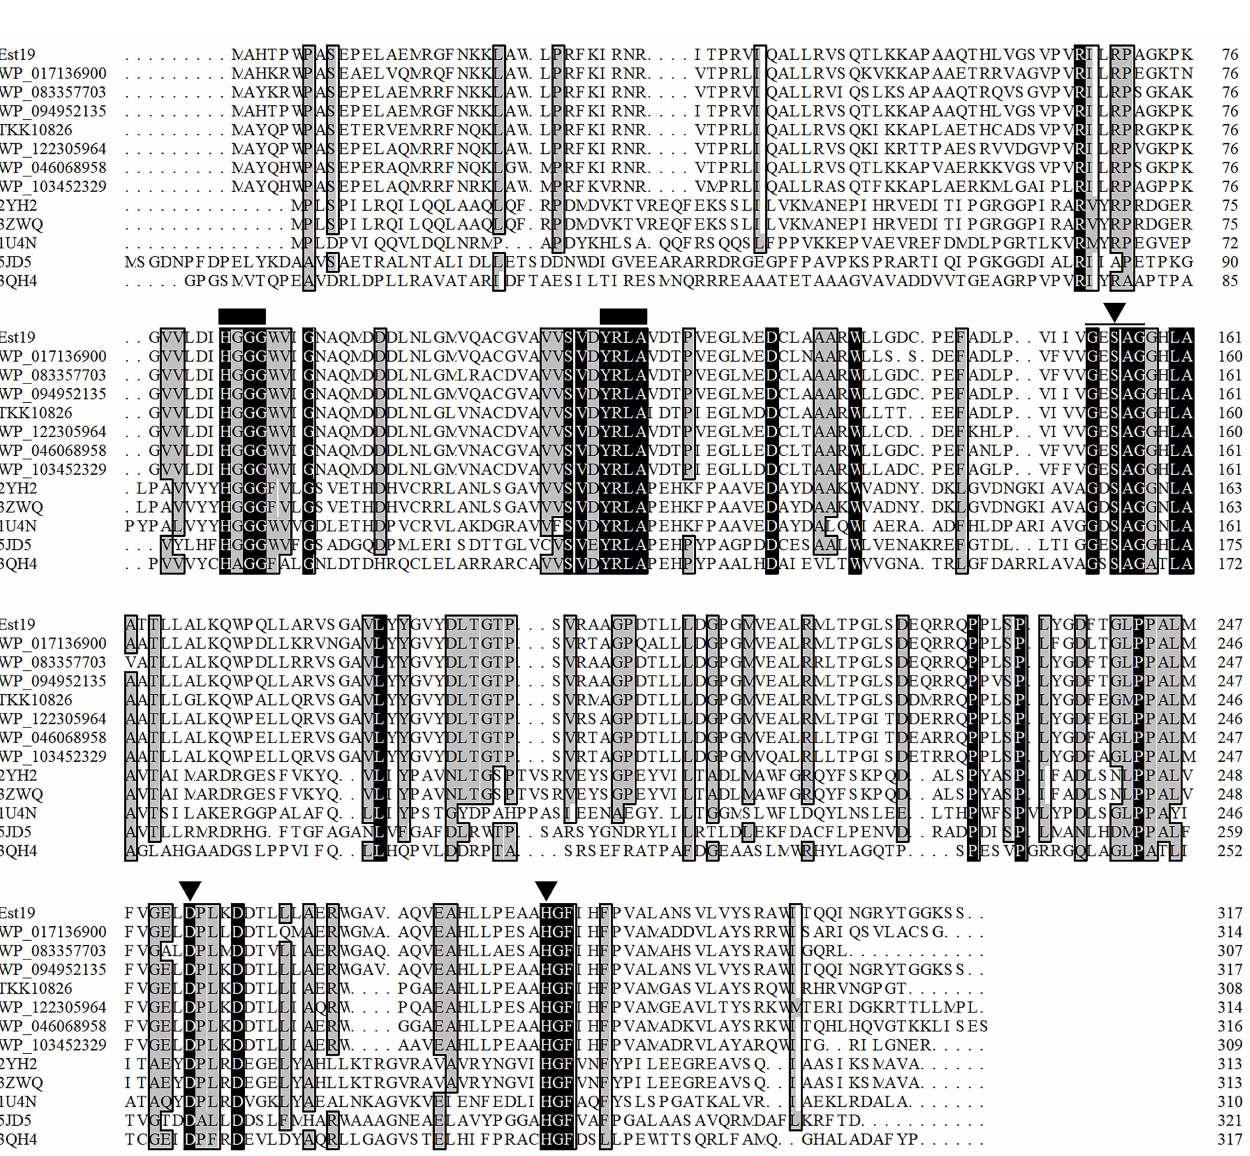
Figure 1. Sequence alignment of Est19 and members of the HSL family. Identical residues are shown in white on a black background, and similar residues (homology ≥ 75%) are on a grey background. Black triangles indicate residues forming the catalytic triad Ser, Asp, and His. Black squares indicate conserved